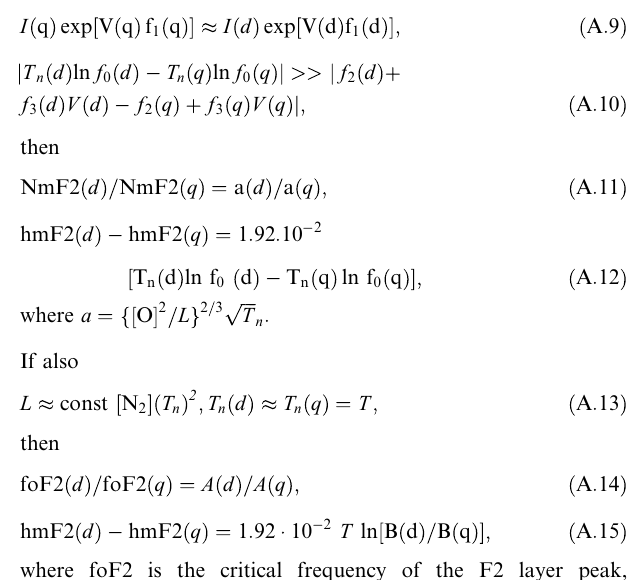
Table 2. In Eqs. A.1-A.3 the values of (cid:137) O (cid:138);(cid:137) O 2 (cid:138);(cid:137) N 2 (cid:138); T n ; T e ; T i ; T v ; and W are taken at h 0 altitude. We take into account the input of